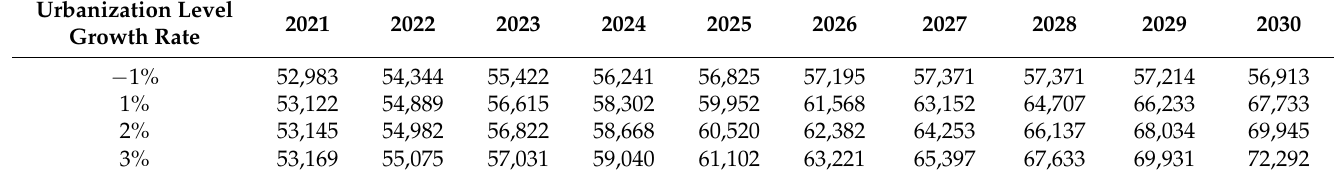
Table 8. Predicted power consumption of the secondary industry under different growth rates.